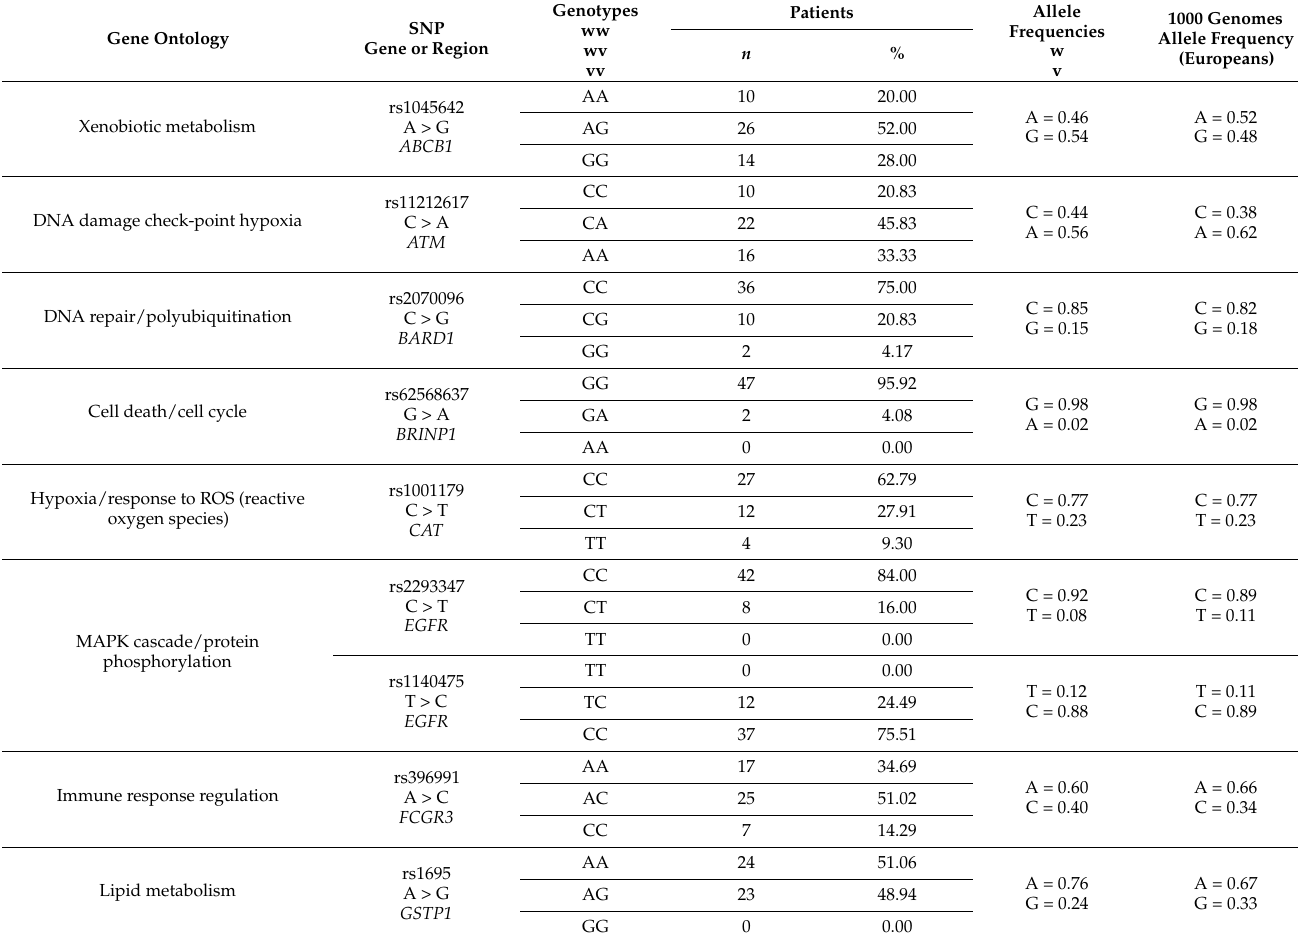
Table 2. Genotypes shown as allelic frequencies of the 28 SNPs examined (w = wild-type allele, v = variant allele). Genes are classified according to gene ontology (the biological processes they affect). Allele frequencies from the 1000 Genomes database are indicated (– = no data